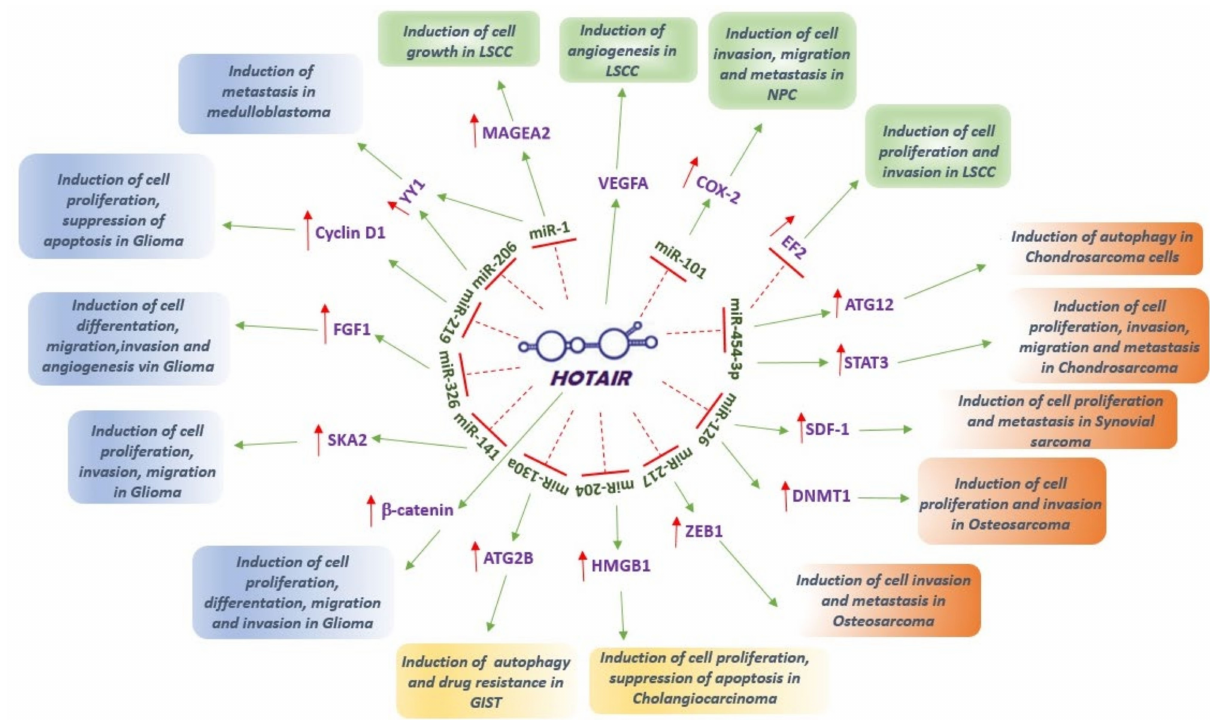
Figure 1. Schematic representation of the main molecular pathways related to HOTAIR deregulation in rare cancers. In rare tumors of the head and neck rare (green box), HOTAIR promotes cell growth, proliferation, migration and invasion through the direct interaction and consequent inhibition of different miRNAs: HOTAIR/miR-1 functional interaction promotes MAGEA2 expression, which is able to suppress p53-dependent apoptosis in response to drugs, decrease cellular senescence and increase cell proliferation in LSCC cells; HOTAIR inhibits miR-454-3p that target EF2, the principal target of the tumor suppressor pRB, reducing tumor suppression in LSCC cells; HOTAIR/miR-101 functional interaction in NPC cells induces COX2 expression, a regulator of tumor metabolism, angiogenesis and tumor microenvironment. In LSCC cells, HOTAIR interacts with VEGFA promoting angiogenic processes. In soft tissue tumors (orange box), HOTAIR interacts with different miRNAs leading to their inhibition and promoting cell proliferation, migration and invasion of tumor cells: HOTAIR/miR-454-3p functional interaction induces (i) ATG12 expression, a positive regulator of autophagic vesicle formation, and (ii) STAT3, involved in regulation of cancer inflammation and metastasis, in chondrosarcoma cells. HOTAIR/miR-126 functional interaction promotes (i) SDF-1 expression, the main receptor of the metastasis inducer gene CXCR4 able to modulate proliferation/survival and EMT of synovial sarcoma cells, and (ii) DNMT1, involved in cancer stem cell maintenance and tumorigenesis, in osteosarcoma cells. HOTAIR inhibits miR-217 upregulating ZEB1, a potent inducer of EMT, in osteosarcoma cells. In rare digestive system tumors (yellow box), HOTAIR interacts with miR-204 to upregulate HMGB1 gene, a crucial regulator of inflammation and cancer progression, in cholangiosarcoma cells, and with miR-130a to induce ATG2B expression promoting autophagy in GIST cells. In central nervous system tumors (blue box), HOTAIR is able to induce b-catenin expression, modulating Wnt signal pathways in glioma cells, and establishes functional interaction with different miRNAs to promote cell proliferation invasion and migration: HOTAIR/miR-141 interaction induce upregulation of SKA2, a gene involved in cell cycle regulation, in glioma cells; HOTAIR/miR-326 interaction leads to the upregulation of FGF1, involved in the repairing progress of damaged, in glioma cells; HOTAIR inhibits miR-219 upregulating Cyclin D1, a key regulator of cell cycle progression, in glioma cells; HOTAIR/miR206 functional interaction induces YY1 expression promoting metastatic progression in medulloblastoma cells. Green arrow connects related pathways and function; Red arrow indicates induction of expression; T indicates inhibition of